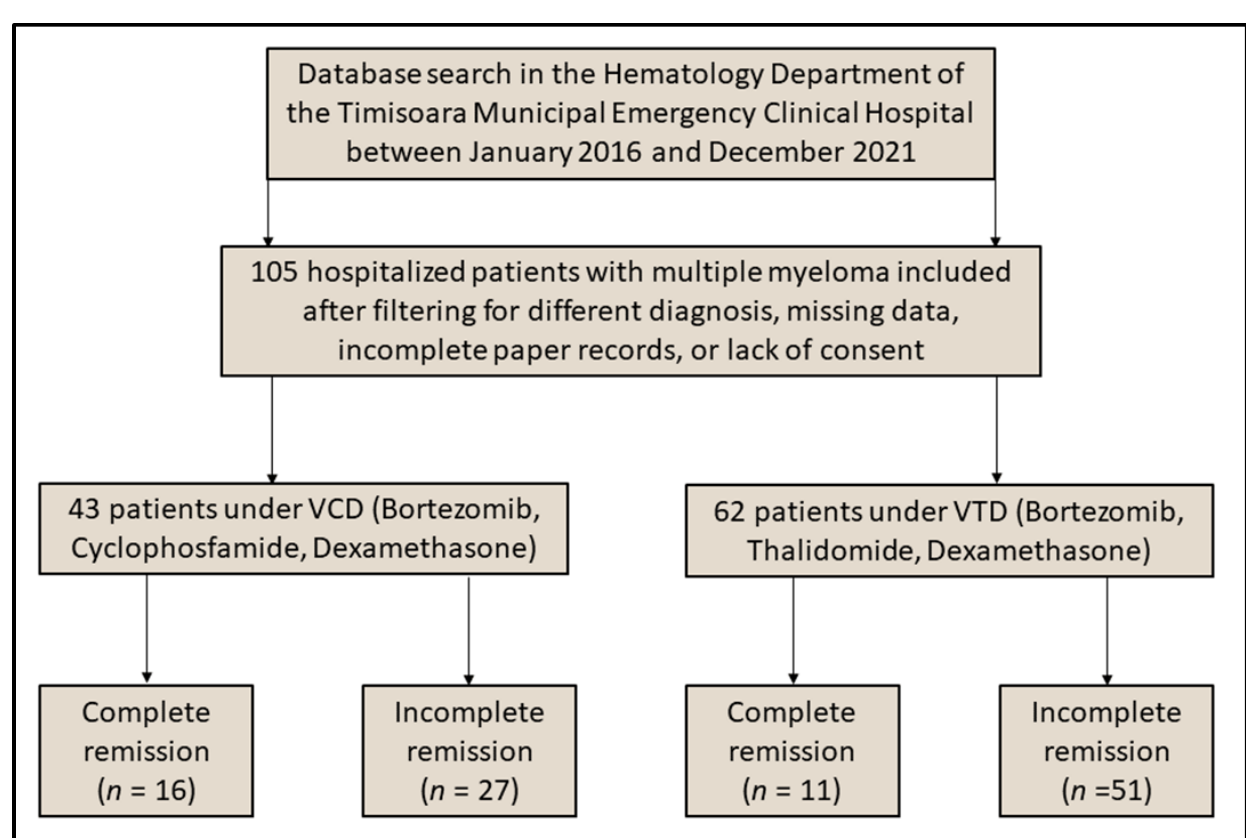
Figure 1. Flowchart of patients considered for inclusion in the study.